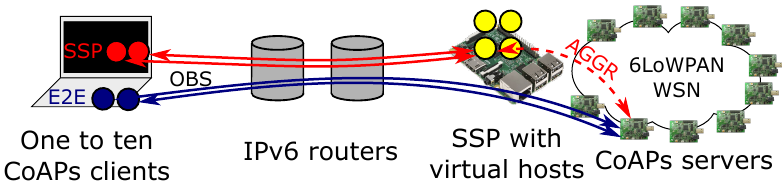
Figure 8. Evaluation setup: a variable number of CoAPs clients observes one of two resources on either the virtual host (SSP) or the sensor node